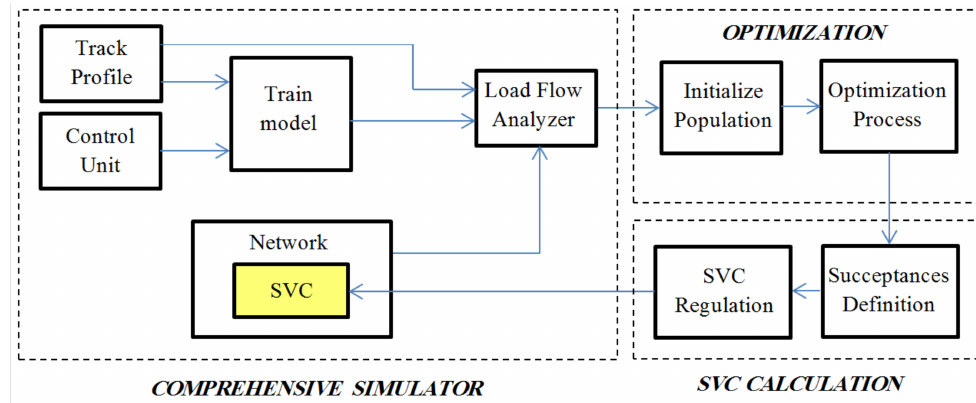
Figure 7. Block diagram of the proposed